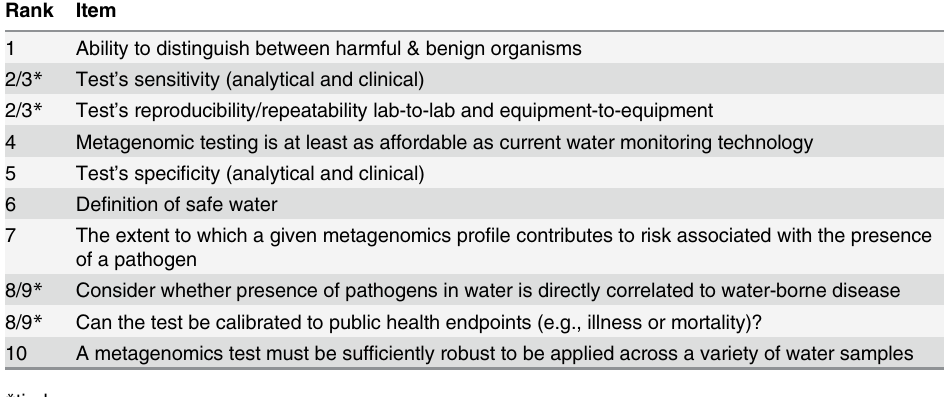
Table 3. Top 10 Decision Criteria to Adopt Metagenomic Testing for Water